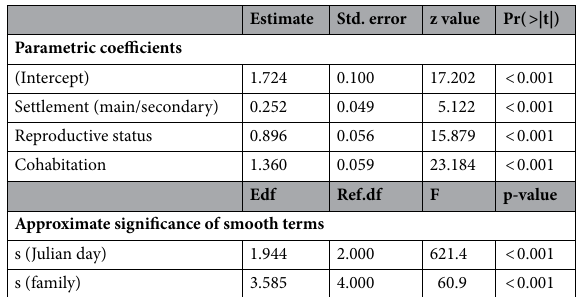
Table 3. Effect of predictor variables (settlement, reproductive status, cohabitation, Julian day, and family ID) estimated by the Generalised Additive Model (with Poisson error distribution) fitted to predict the length of inhabitation period by porcupine families in a settlement in Central Italy. Coefficients (Estimate) for the linear terms in the model (settlement, reproductive status, cohabitation), standard errors (Std. Error), test statistic and its significance (z value and p-value) are shown in the first part of the Table. Effective degrees of freedom (edf, representing the complexity of the smooth terms), together with test statistic (F), its significance (p-value) and degree of freedom (Ref.df) used to assess overall significance of the smooth terms, are shown in the second section.